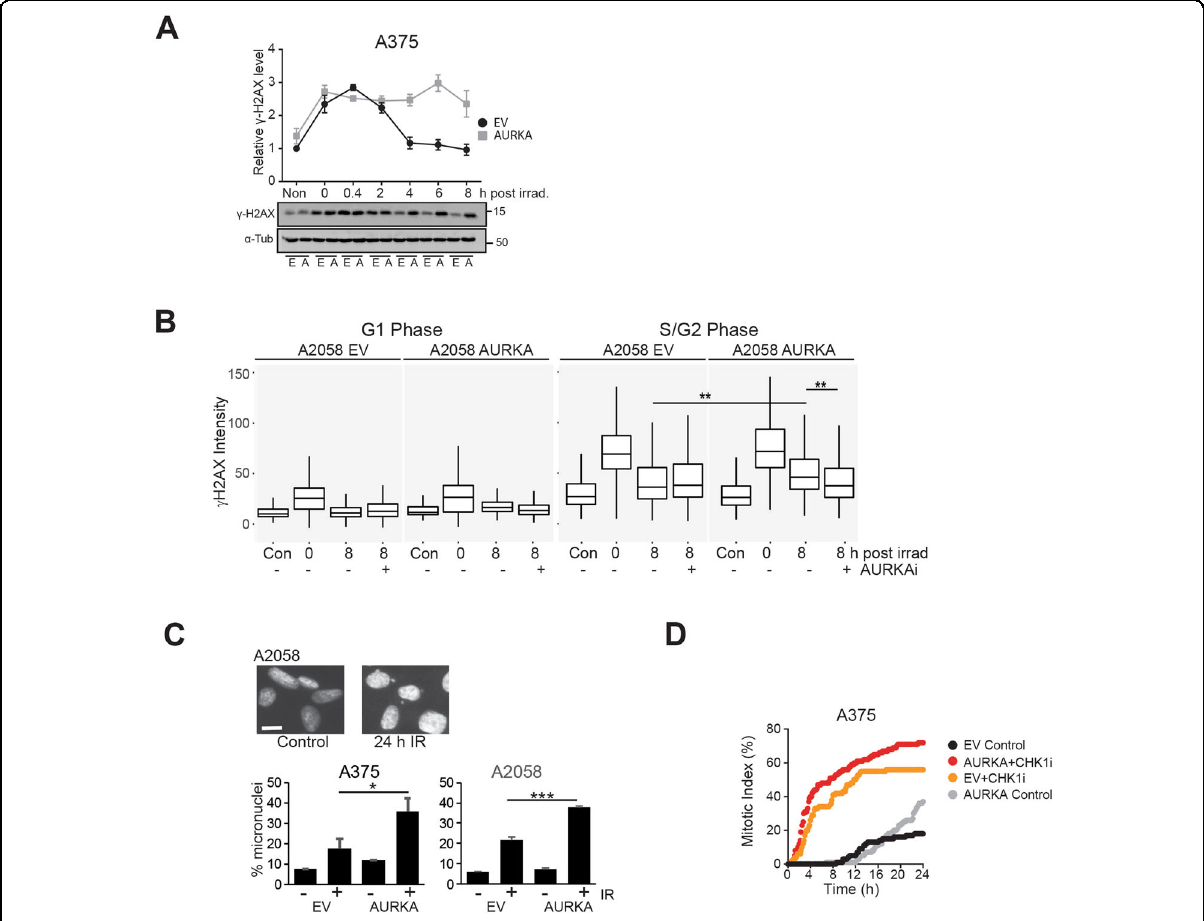
Fig. 5 AURKA overexpression reduces HRR ef fi ciency. A Time dependent immunoblot analysis for γ H2AX levels and quanti fi cation. Asynchronous A2058 EV and AURKA overexpressing cells were exposed to γ radiation (10 Gy), harvested at indicated hours after exposure, and immunoblotted for γ H2AX. α -Tubulin was used as a loading control. [B] DNA content (DAPI intensity) of cells determined by high content imaging. γ -H2AX intensities were plotted against DNA content. Using the DNA pro fi le, G1 and S/G2 populations were identi fi ed. B Box and whisker plot shows γ H2AX intensities in G1 and S/G2 cell cycle phases. A2058 EV and AURKA overexpressing cells were either fi xed as unirradiated controls (Con) or irradiated with 6 Gy and fi xed immediately after irradiation (0 h), or after 8 h either without or with AURKAi MK5108 (1 μ M). DNA content (DAPI) and γ -H2AX intensities were quanti fi ed in G1 and S/G2 cell cycle phases using high content imaging. C Both EV and AURKA over-expressing lines were irradiated with 6 Gy radiation then cells were fi xed 24 h later and stained for DNA. Inset shows the micronuclei formed. The percentage of cells with micronuclei was in triplicate samples for each condition and cell line. 300 – 1000 cells were counted for each replicate. D A375 EV and AURKA overexpressing cells were exposed to γ radiation (10 Gy), treated without or with CHK1i then followed by time lapse microscopy. The cumulative mitotic index for each culture was